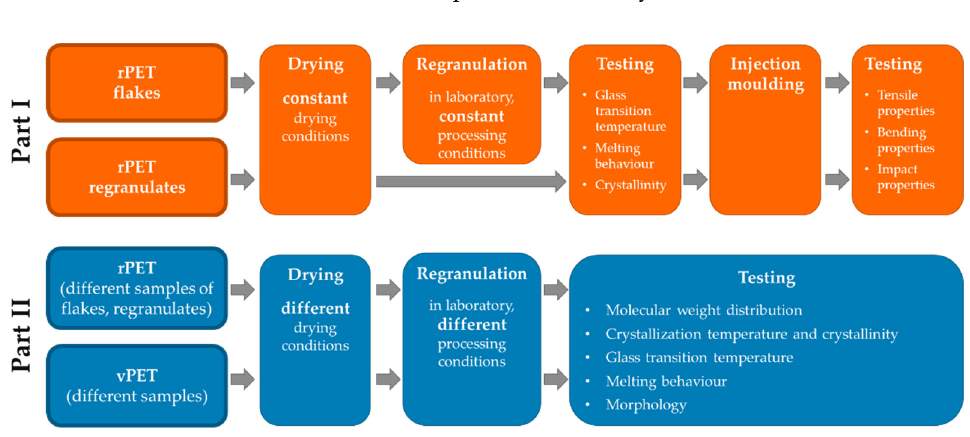
Figure 1. Summary of the materials and methods for the first and the second part of this